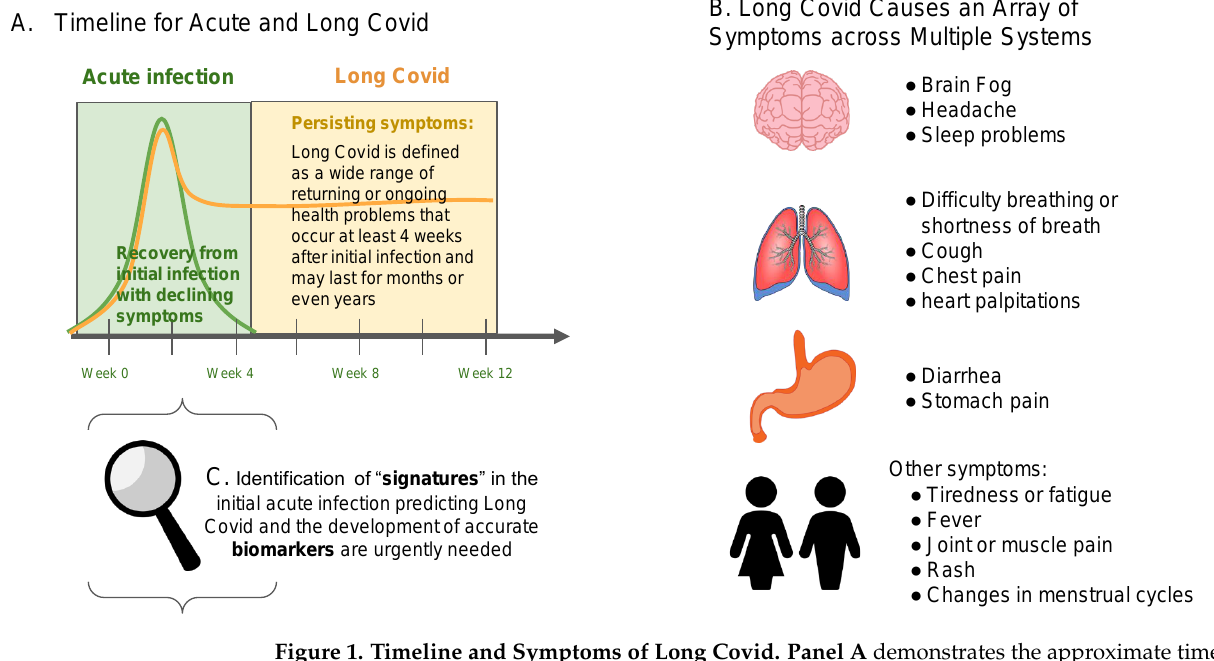
Figure 1. Timeline and Symptoms of Long Covid. Panel A demonstrates the approximate timeline for acute and Long Covid manifestation following infection with SARS-CoV-2 (note: the CDC states that four weeks after infections is when Long Covid conditions can first be identified); Panel B depicts the array of heterogenous symptoms caused by Long Covid across multiple systems; Panel C demonstrates the early time periods where accurate biomarkers identifying the onset of Long Covid could be most beneficial to attenuate disease